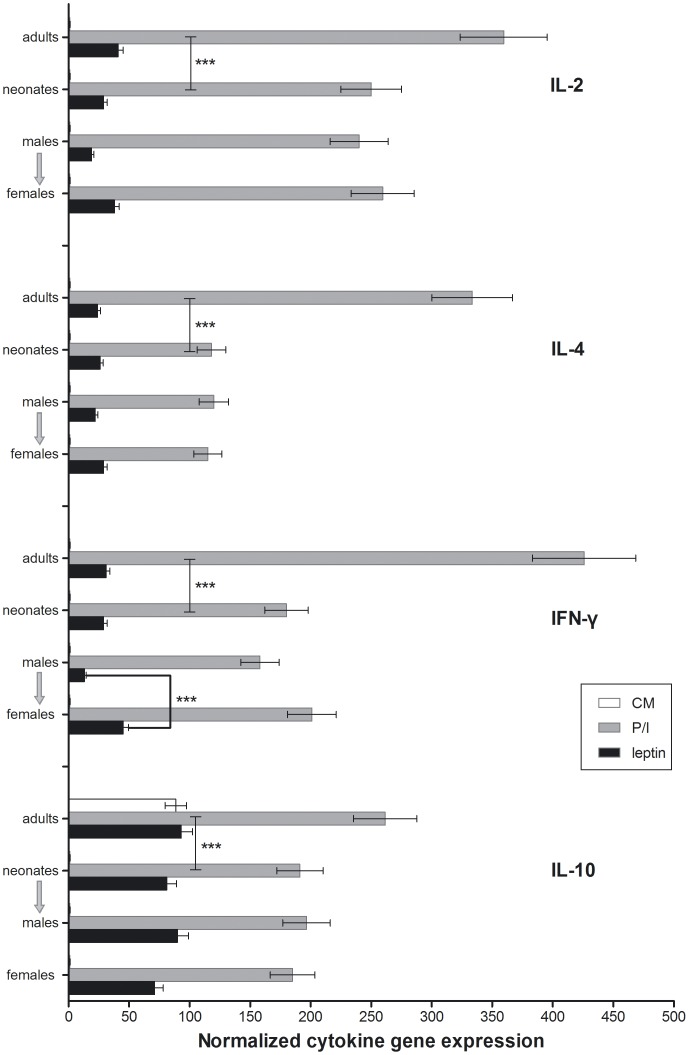
Cytokine gene expression (mean ±%CV) by CBMC of 40 healthy neonates and PBMC of 20 adults.The cells were cultured for 8h in plain culture medium (CM) or with mitogens (P/I) or with recombinant leptin (leptin). The levels of expression were normalized according to β2m expression levels. Statistically significant differences are indicated by asterisks (***, P<0.001, compared with 2-way ANOVA).